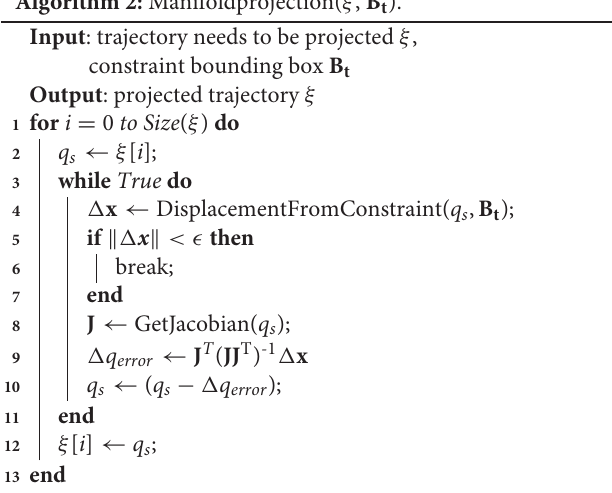
Algorithm 2: Manifoldprojection( ξ , B t